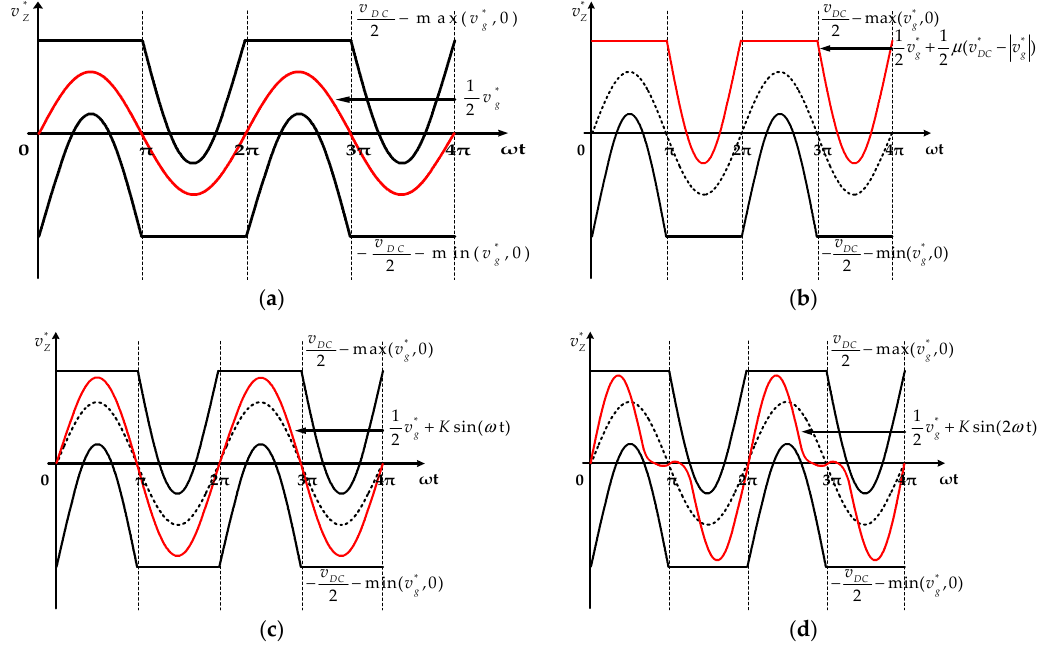
Figure 4. Limitation pole voltage v A 0 * with the offset voltage v z *. ( a ) v z * = 0; ( b ) using distribution factor μ ; ( c ) fundamental component; and ( d ) second-order harmonic component.